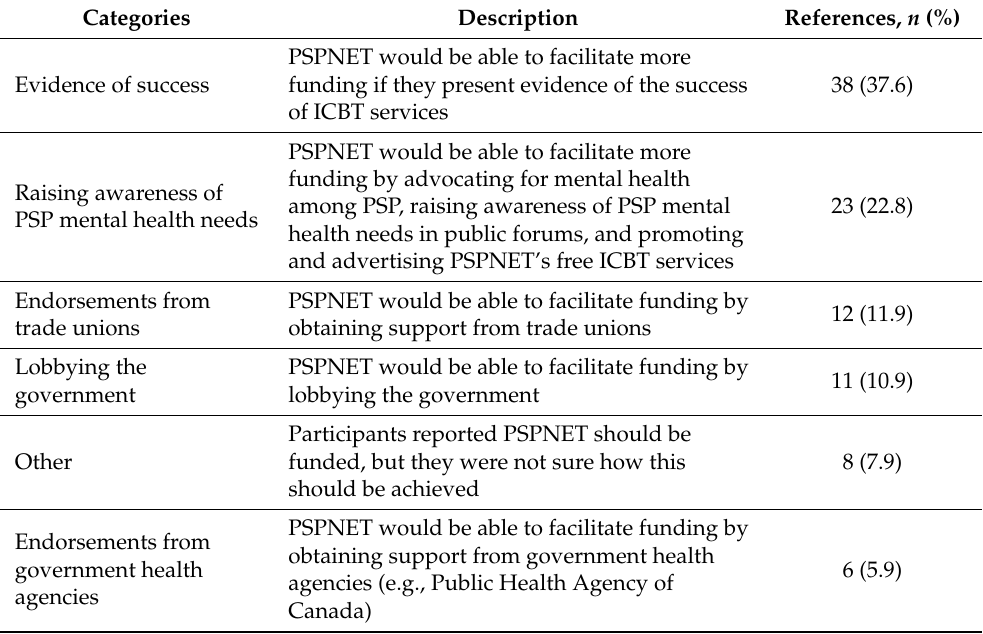
Table 7. Perceptions of factors that will facilitate funding of PSPNET ( n =